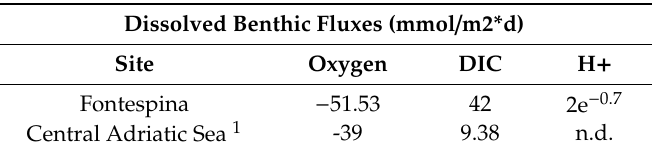
Table 2. Oxygen, DIC and H + dissolved benthic fluxes measured by Ada_N in Fontespina and on pelitic sediments of the Central Adriatic Sea.